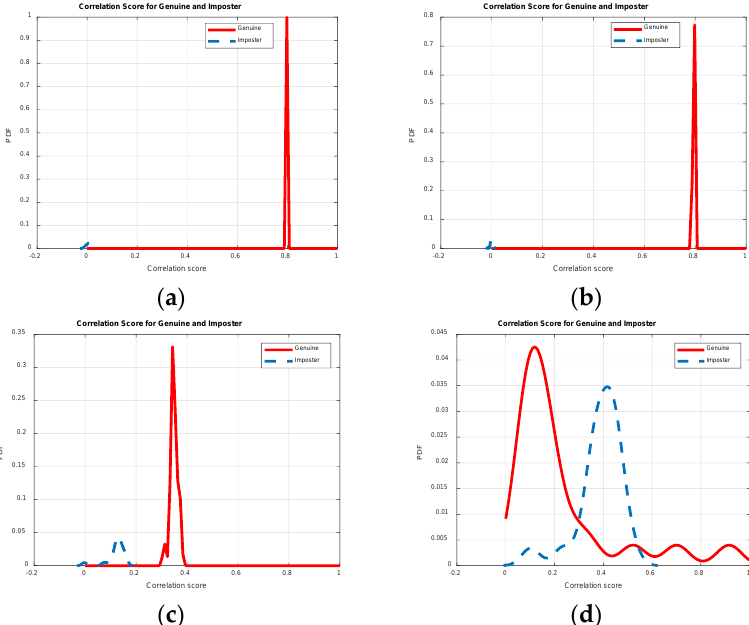
Figure 21. Probability distributions for cancellable face recognition frameworks (for FERET dataset) for ( a ) CFR1, ( b ) CFR2, ( c ) homomorphic transform followed by salting and ( d ) homomorphic transform followed by random kernel convolution.